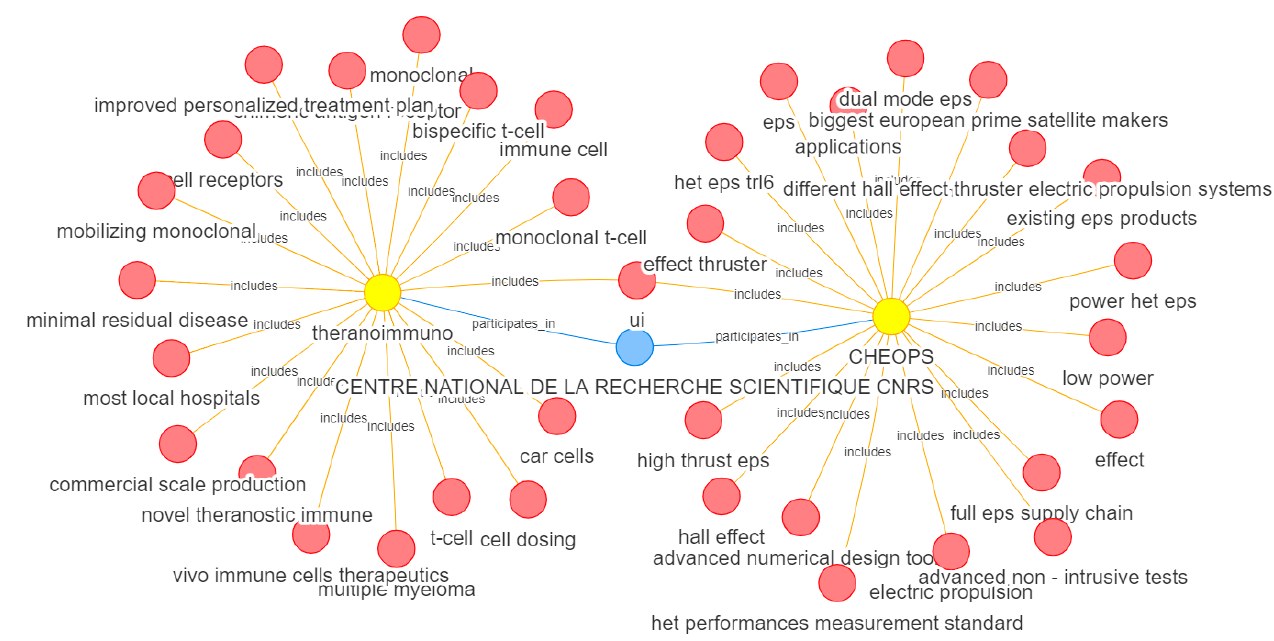
Figure 4. Visualization of a specific organization and some of its projects and respective keyphrases.